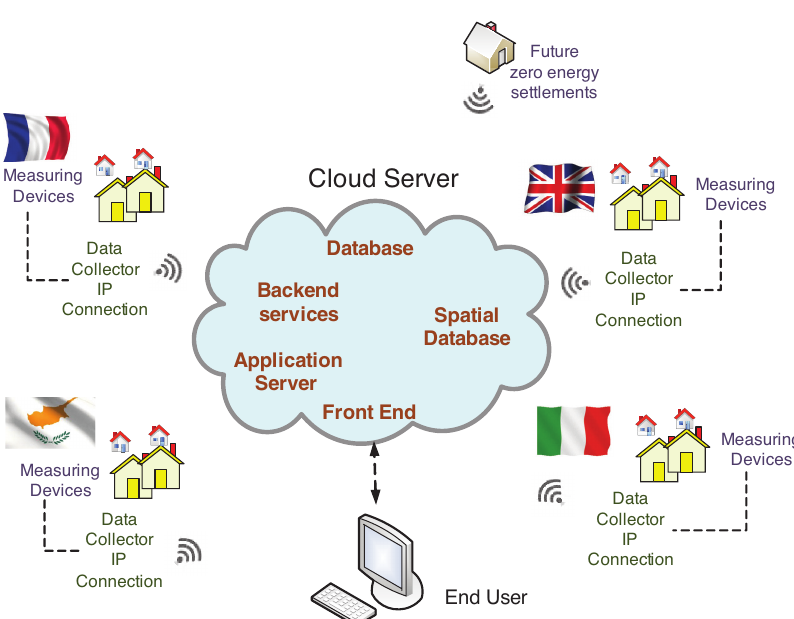
Figure 3. Overall layout of the Web-GIS monitoring platform. Source: